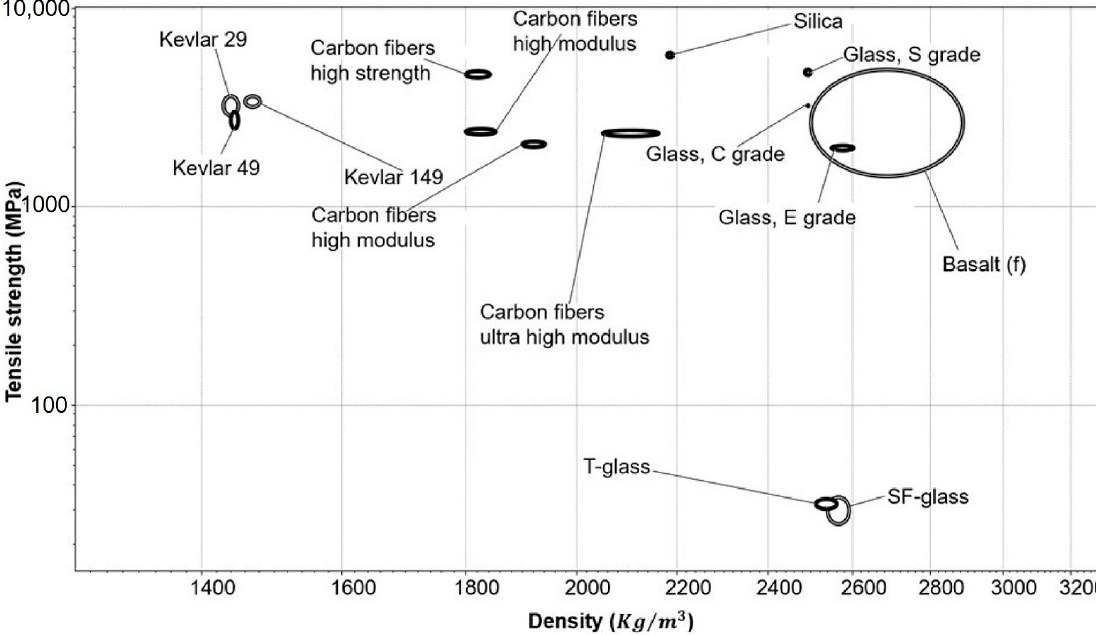
Figure 3. Tensile strength versus density (Generated by CES EduPack,